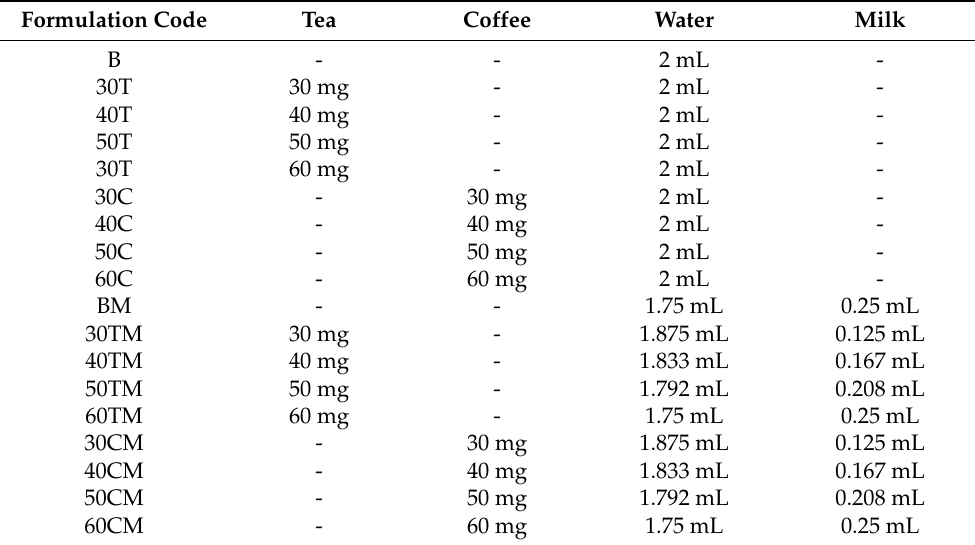
Table 3. Formulation of PAA hydrogels loaded with black tea dry extract and coffee